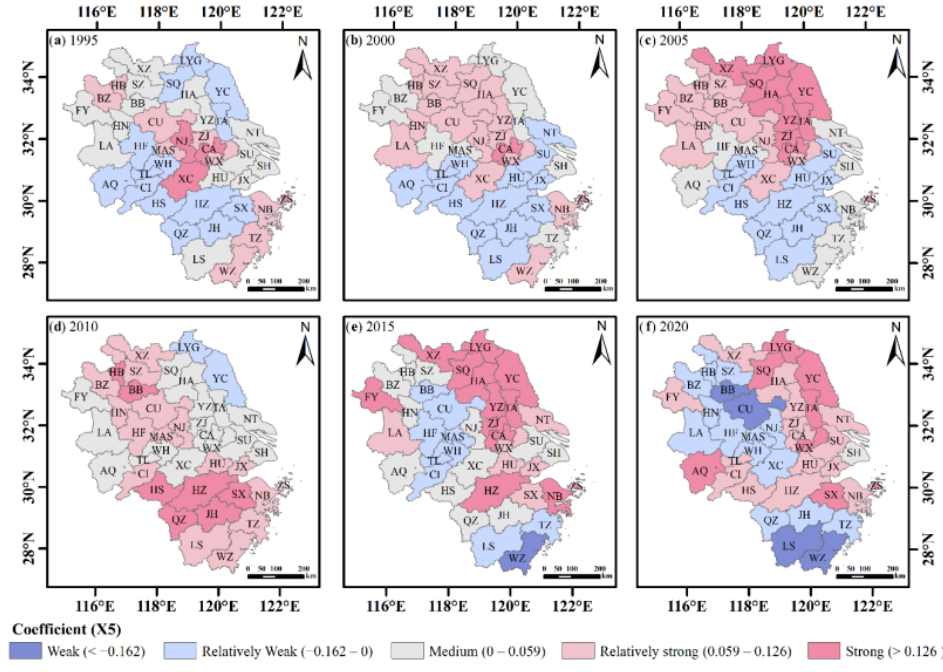
Figure A5. Spatial distribution of the regression coefficients of the industrial structure.